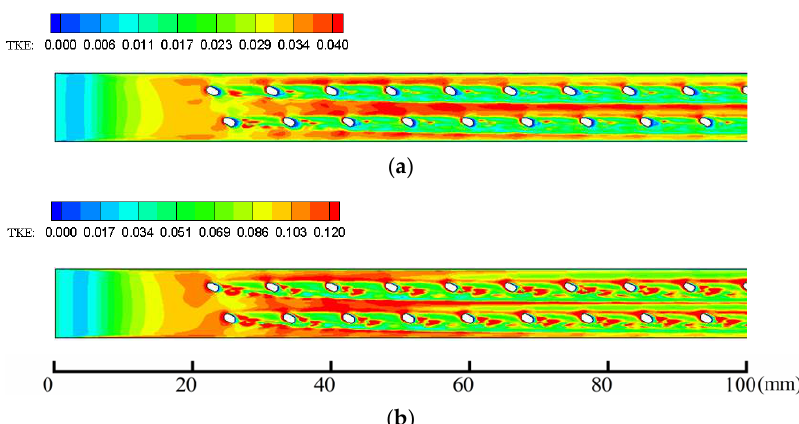
Figure 10. Turbulent kinetic energy on ( x , z )-plane at y / y 0 = 0.68 for R1 ( a ) and R7 ( b ) cases.